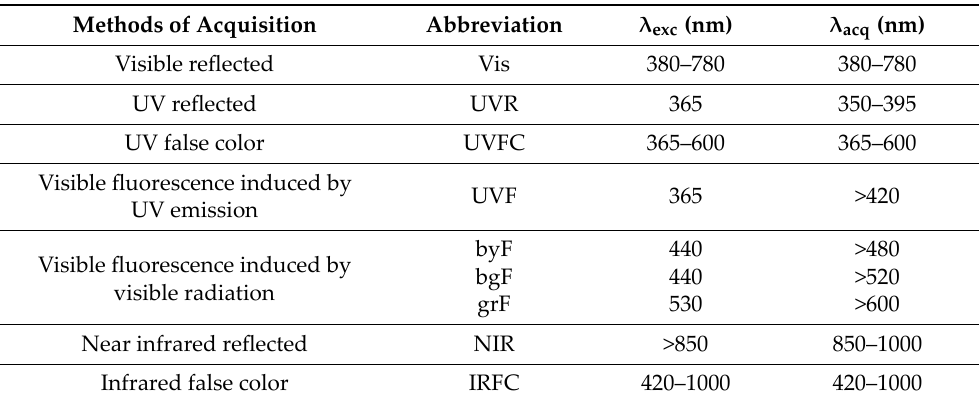
Table 2. The methods of imaging acquisition with specifications of excitation ( λ exc ), acquisition ( λ acq ) wavelengths and abbreviations used in the paper.